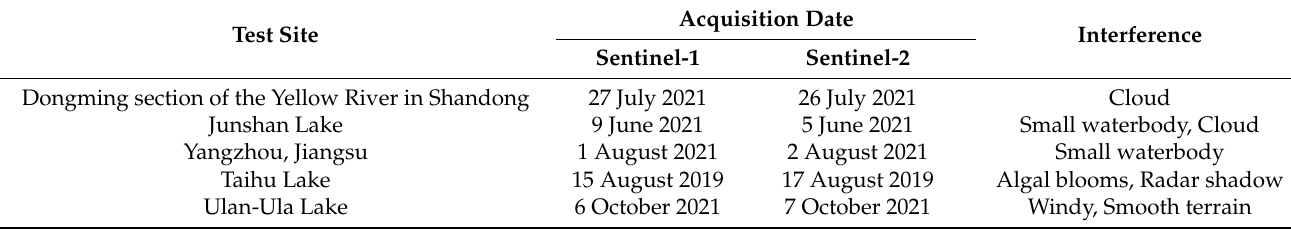
Table 1. Description of Sentinel-1/2